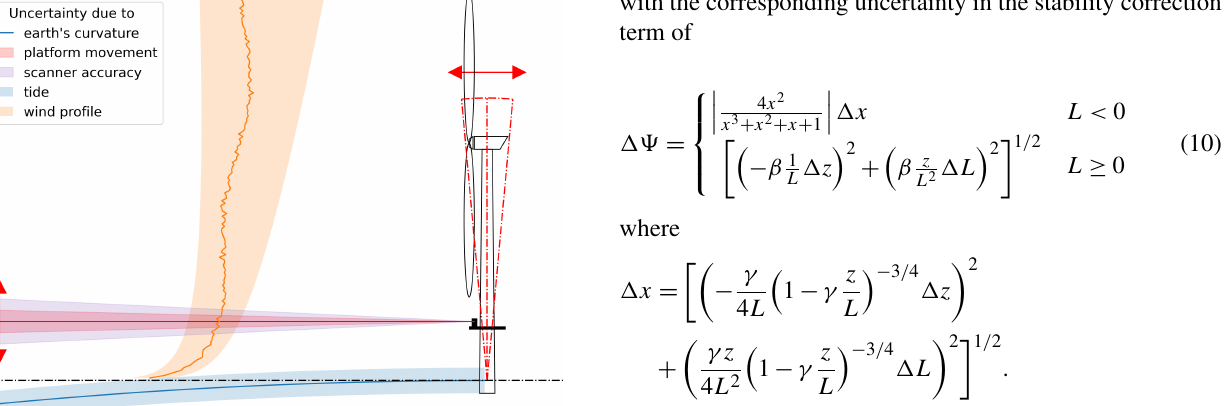
Figure 2. Illustration of different sources of uncertainty for wind speed estimates in long-range Doppler lidar measurements on an offshore platform like the TP of an offshore wind turbine. Besides the general uncertainty in the LOS wind speed measurement the main source of uncertainty is the varying measurement height due to lidar scanner misalignment (purple) and platform tilts and move- ments (red), e.g. due to the turbine’s thrust. Curvature of the earth (blue) and tide (light blue) add to the height uncertainty. As a con- sequence of known height errors measured wind speeds need to be transformed back to the desired height; thus the lack of knowledge of the prevailing wind profile introduces additional uncertainty (or-